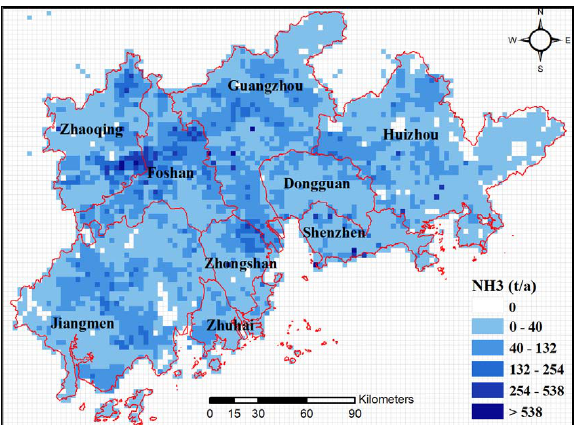
Fig. 7. Spatial distributions of total NH 3 emissions in the PRD region.